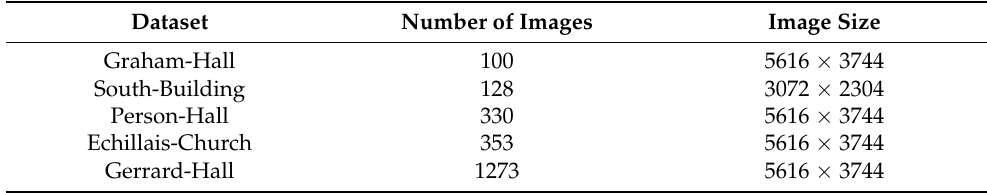
Table 1. Public dataset